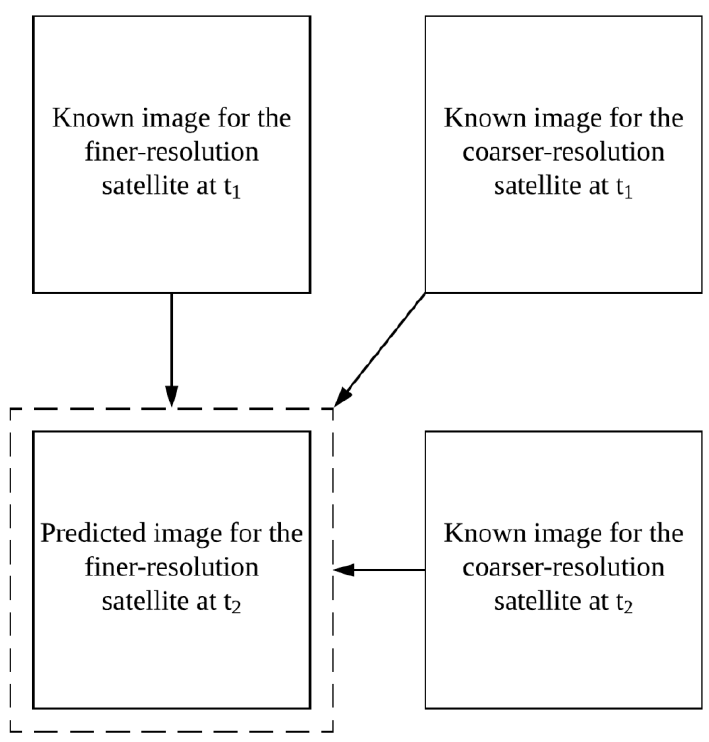
Figure 1. Architecture of traditional spatio-temporal data fusion. Suppose t 1 represents the known date and t 2 represents the prediction date.